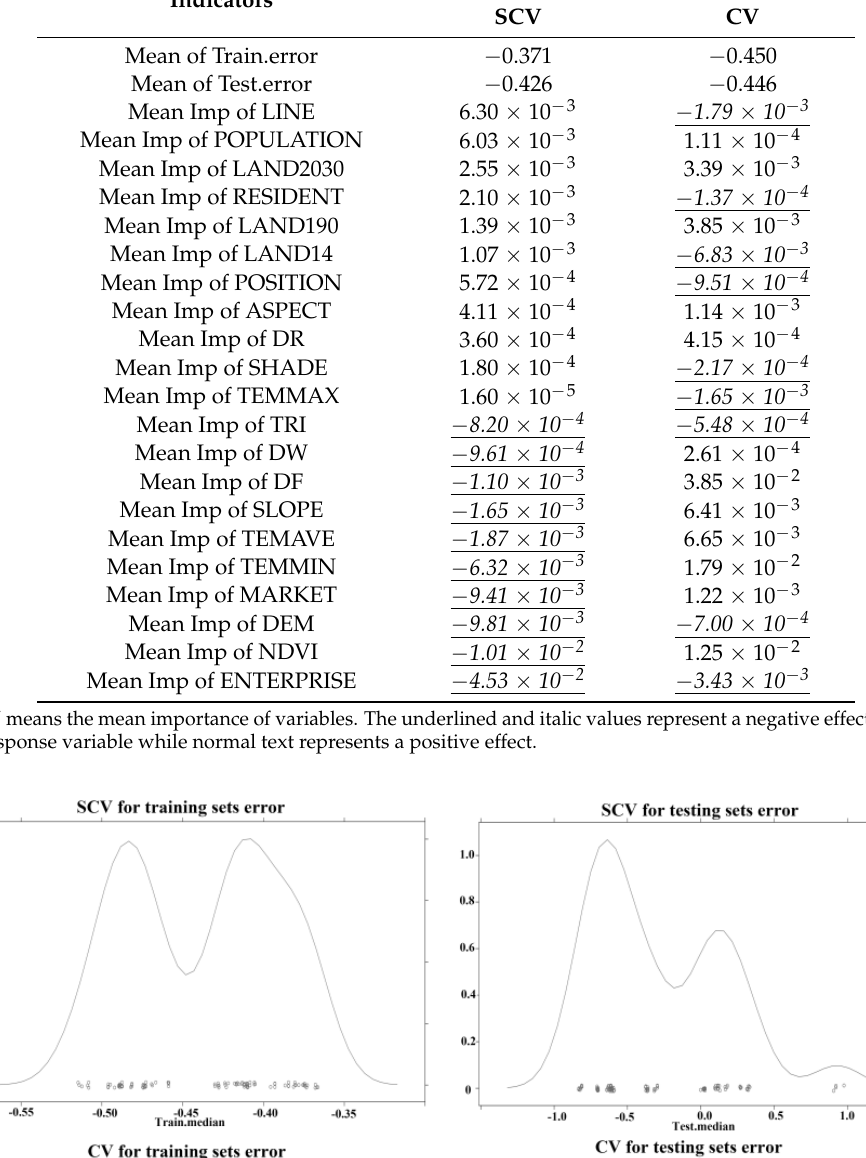
Table 3. Results of SCV and CV for linear regression.